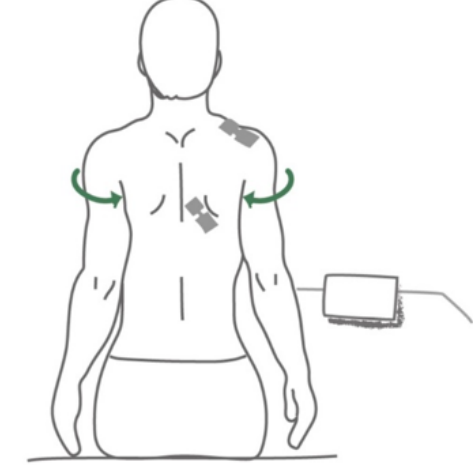
Figure 1. The eleRehab system. Left figure shows a physiotherapist calibrating the system for the patient using the calibration octopus and a tablet. Right figure shows the patient wearing sensors on the back and playing the game on the